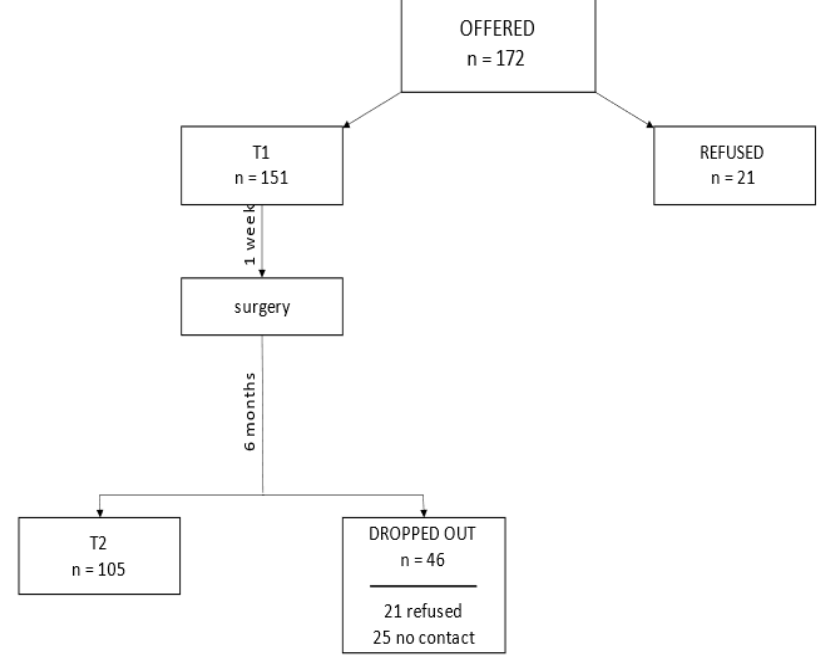
Figure 1. Participant flow.